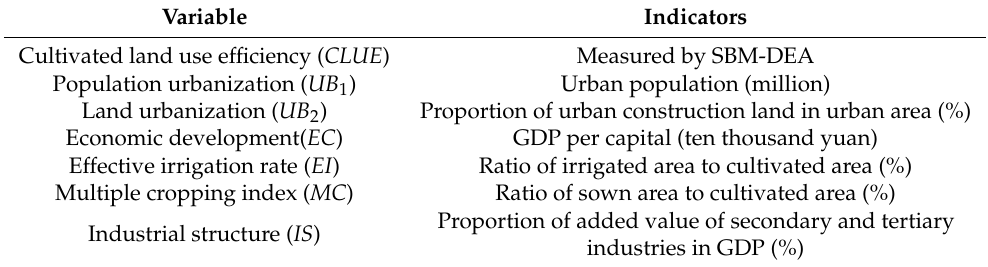
Table 2. Variable selection. Variable Indicators Cultivated land use efficiency ( CLUE